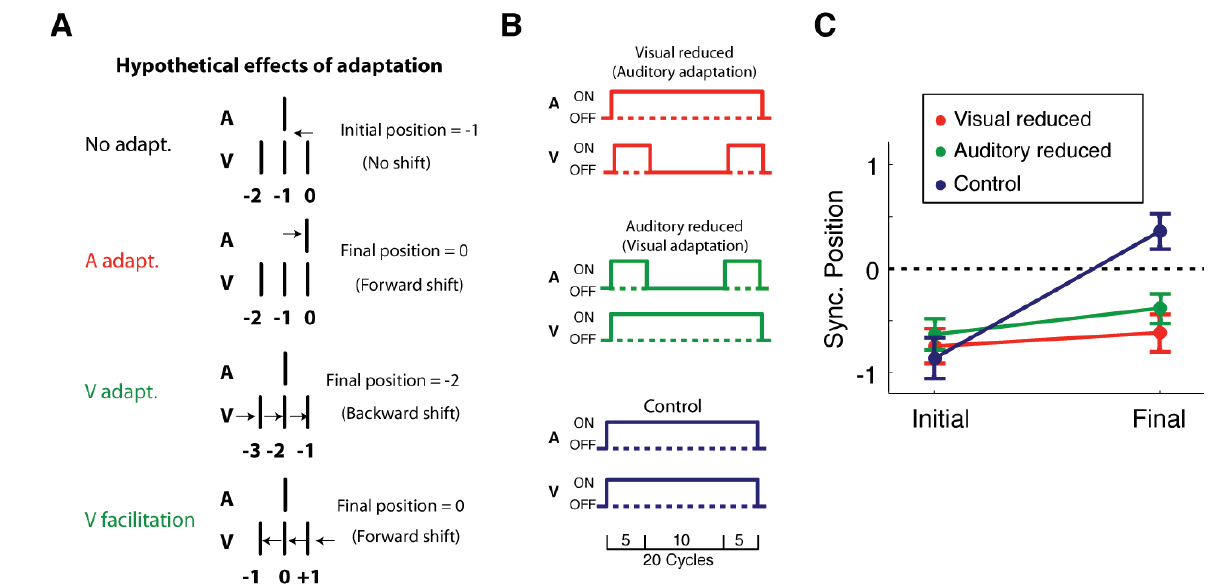
Figure 4. The experiment with a physical disruption of stimulus continuity. A. Hypothetical effects of adaptation are illustrated. Without adaptation, the auditory click is temporally aligned with the visual disk just prior to the veridically synchronous disk (top row). If audiotry adaptation would increase the processing latency for the auditory click, the position of the perceptually synchronous disk would shift forward (second row). Likewise, if adaptation to visual stimuli would increase the latency for vision, the position of the perceptually synchronous disk would shift backward (third row). If continuous presentation of visual disks would result in a shortening of processing latency, the position of the perceptually synchronous disk would shift forward. B . Three experimental conditions are schematically illustrated. In the flash off condition (top), the visual stimulus was turned off during the middle cycles and returned to the screen during the last five cycles. In the sound off condition (middle), the click sound was turned off during the middle cycles. In the control condition (botttom), there was no disruption during the middle cycles. C . The mean synchronous positions for the initial and the final cycles are plotted for each condition. The error bars indicate one s.e.m. (n=6).